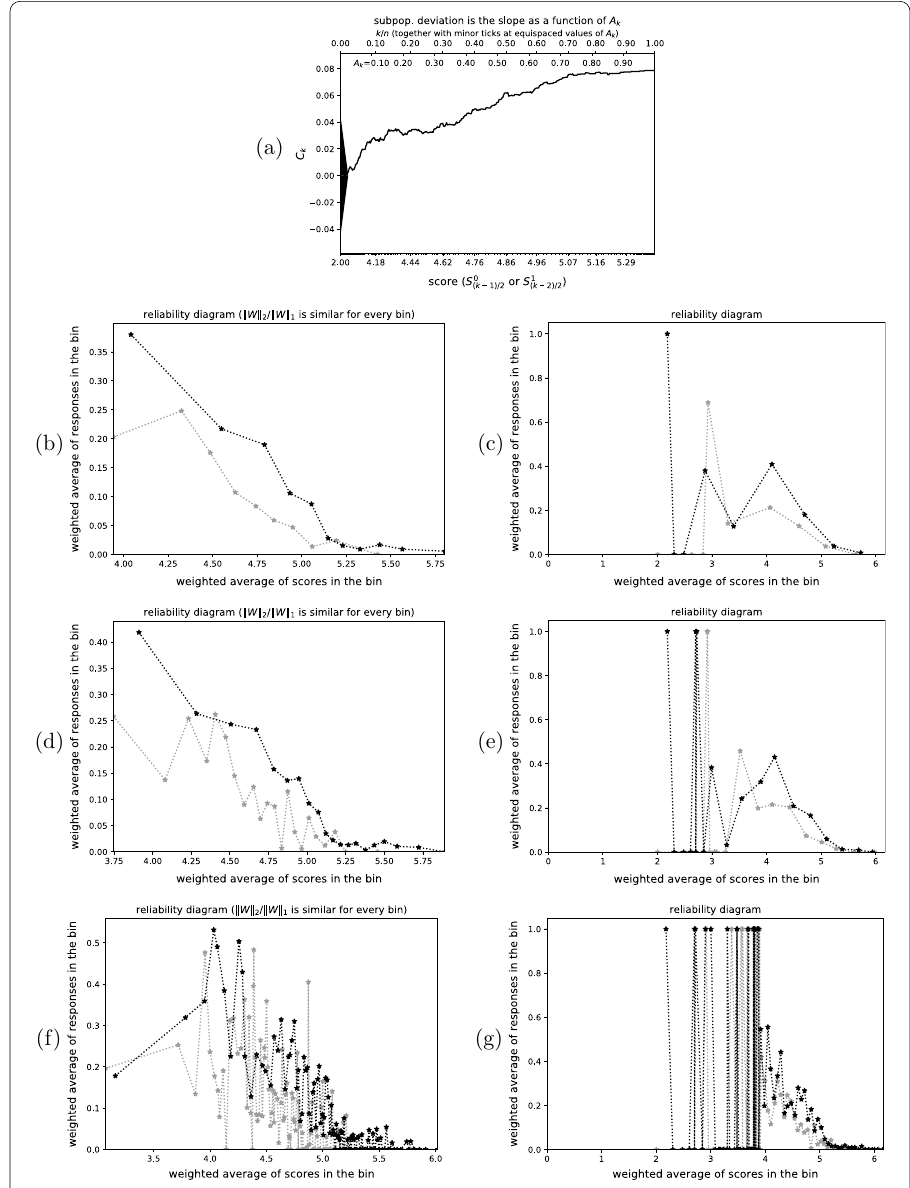
Fig. 11 San Francisco County vs. Kern County; n = 2260; Kuiper’s statistic is 0.07882 /σ = 3.454 , Kolmogorov’s and Smirnov’s is 0.07863 /σ = 3.445 ; only the cumulative graph ( a ) and the reliability diagrams with 100 bins ( f and g ) resolve both the extreme deviation for many low scores and the relatively small deviation for the very lowest scores, whereas 100 bins ( f and g ) produce far too much noise for most scores. The statistics of Kuiper and of Kolmogorov and Smirnov report statistically significant deviation between the